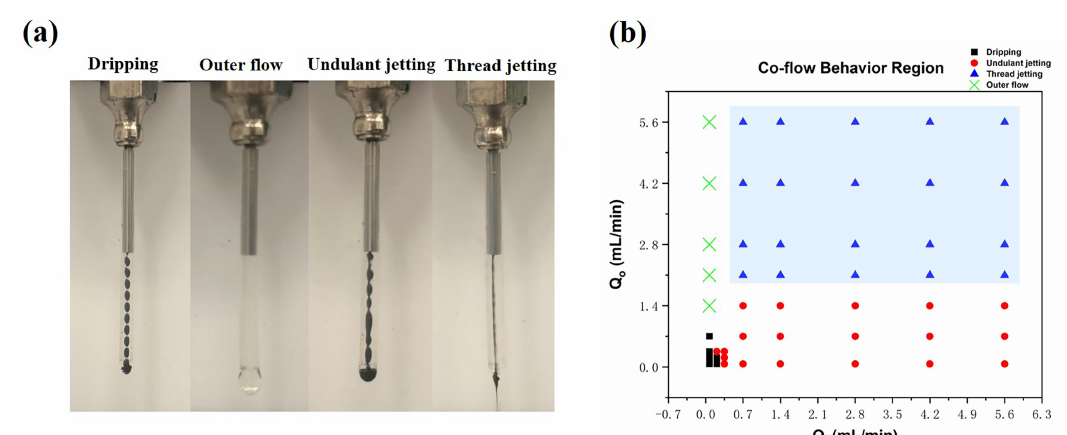
Figure 6. Co-flow behavior regimes and region: ( a ) different co-flow behavior regimes including dripping, outer flow, undulant jetting, and threading jetting; and ( b ) concluded co-flow behavior region.